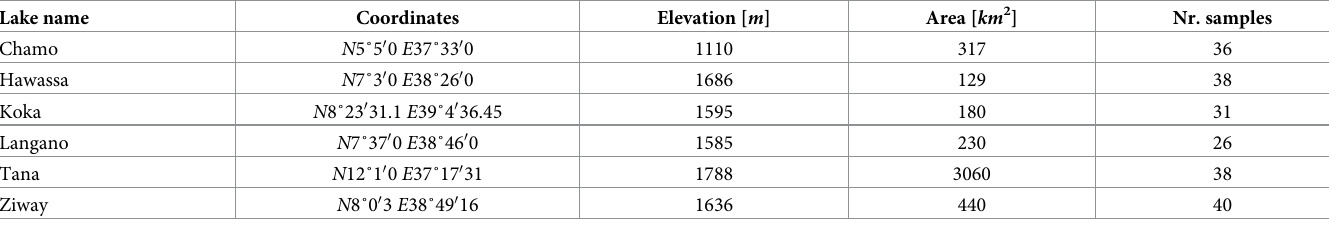
This table lists the six Ethiopian lakes which were visited for sample collection. The lakes are characterized by geographical coordinates, elevation above sea level, area and the number of Nile tilapia sample images which were collected at every